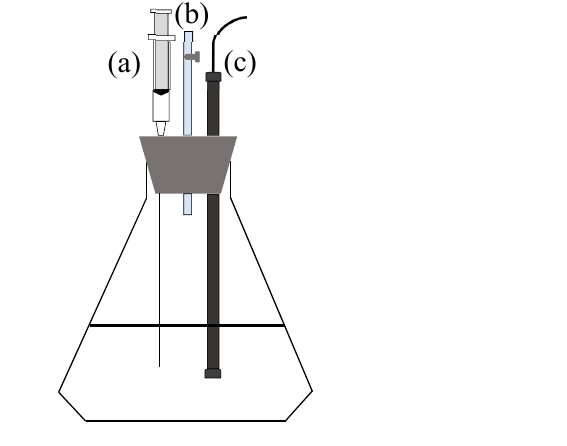
Figure 1. Erlenmeyer flask with a ( a ) sampler, ( b ) suction tube and ( c ) dissolved O 2 (DO) monitor installed on the rubber stopper.